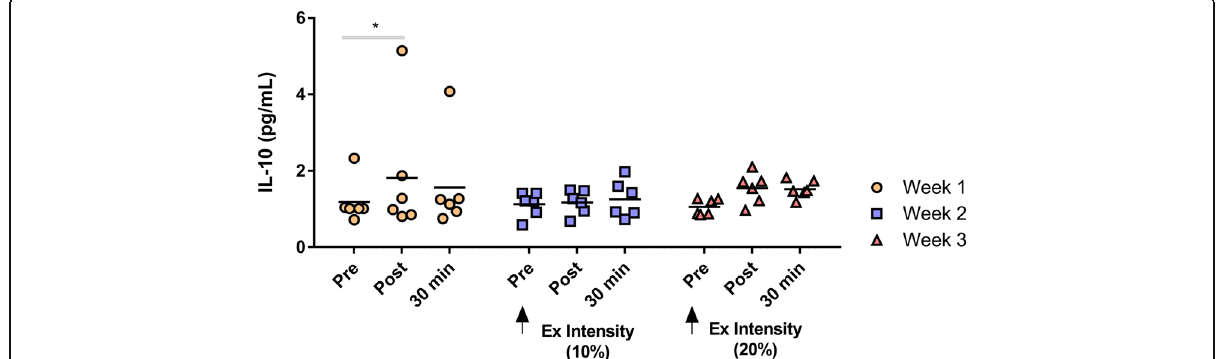
Fig. 6 Plasma [IL-10] during 3 weeks of exercise training ( N = 6). A main effect of time was detected ( P = 0.01). Post hoc Tukey ’ s multiple testing further showed significant differences in plasma IL-10 at Pre vs. Post in week 1. * P < 0.05